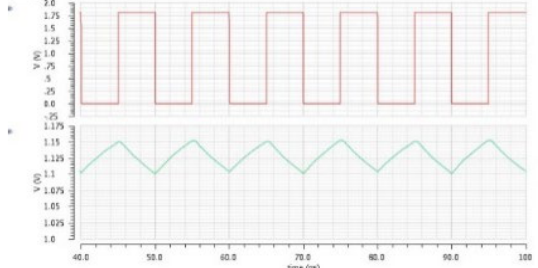
Figure 17. Schematic of proposed dc to dc converter